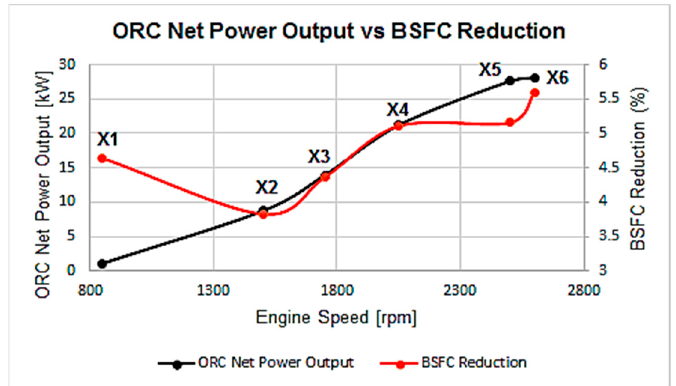
Figure 14. Variation of BSFC in accordance with ORC net power output.